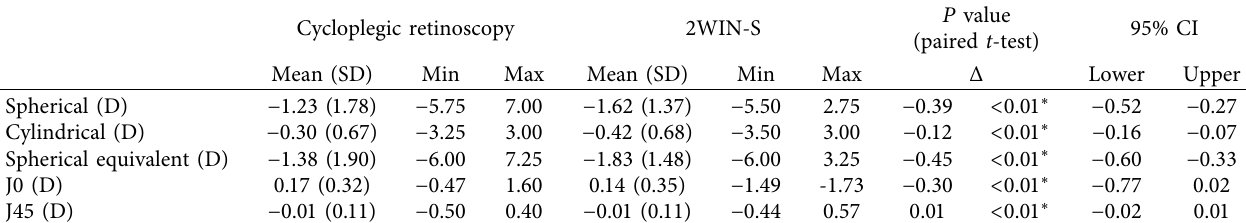
Table 1: Comparison of measurements between cycloplegic retinoscopy and 2WIN-S.